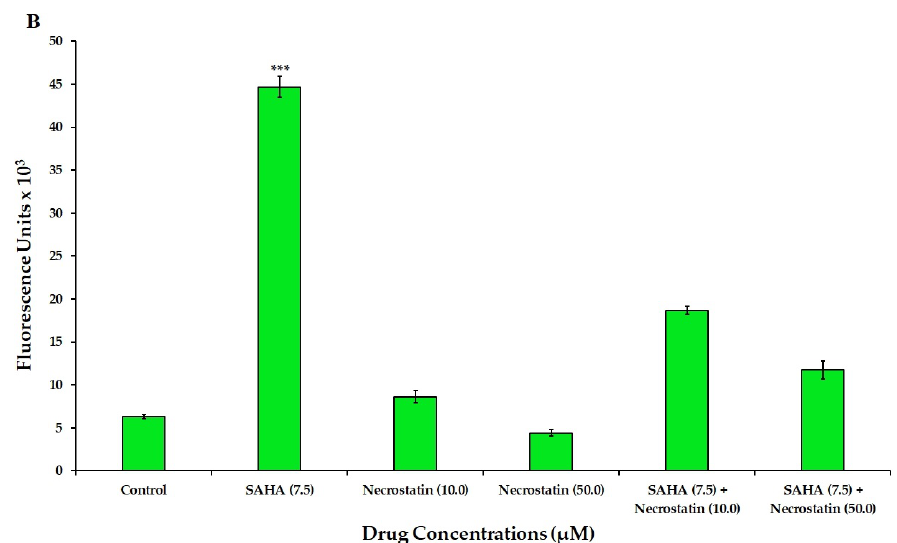
Figure 9. Analysis of necroptosis in MCF-7 cells. ( A ) Confirmation of necroptosis in MCF-7 cells treated with SAHA (7.5 µ M), Necrostatin (10, 50 µ M) individually, and in combinations SAHA + Necrostatin (10 µ M) and SAHA + Necrostatin (50 µ M) using the SYTOX green staining method. ( B ) Confirmation of necroptosis in MCF-7 cells treated with SAHA (7.5 µ M), Necrostatin (10, 50 µ M) individually, and in combinations SAHA + Necrostatin (10 µ M) and SAHA + Necrostatin (50 µ M) with the SYTOX green staining method using a spectrofluorometric assay in a 96-well plate. The level of significance is indicated as *** p < 0.001 compared to control.